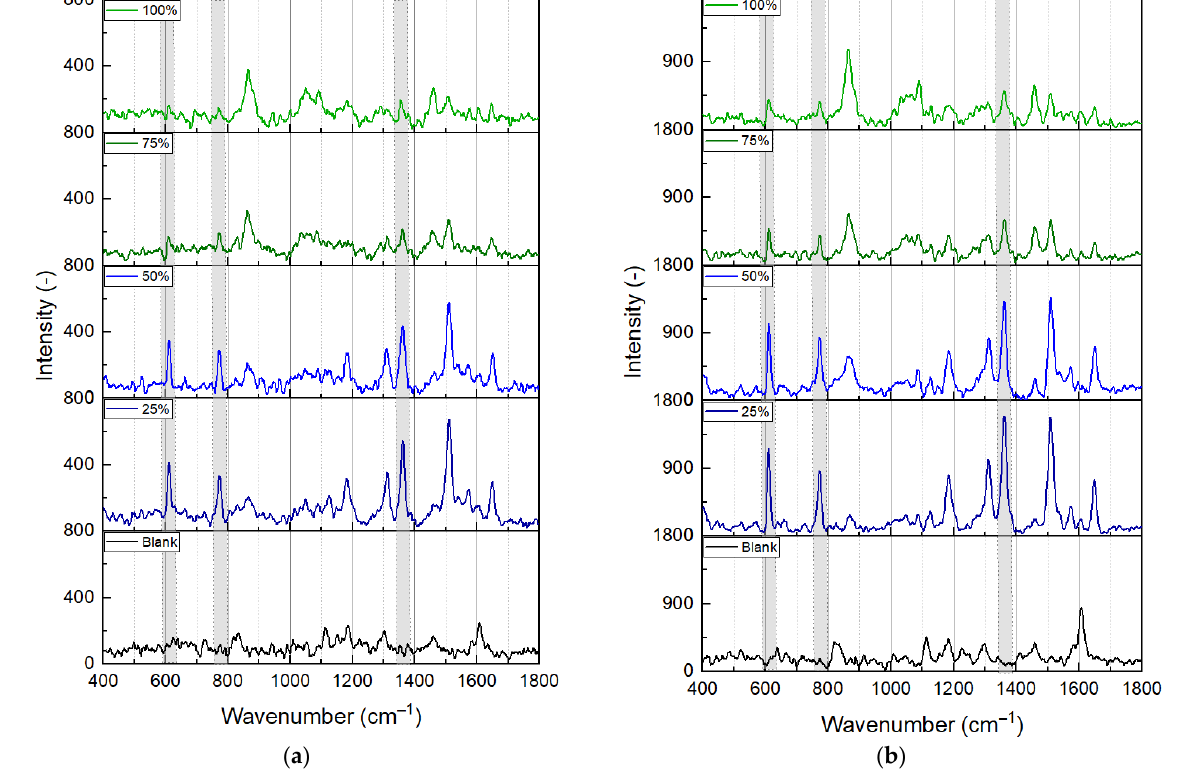
Figure 6. SERS spectra were obtained on a type #2 substrate with 633 nm excitation at different conditions. ( a ) 0.1 mW laser power, ( b ) 0.5 mW laser power. The reference was measured in air, without any sample in the microfluidic cell. The other spectra were obtained in ethylene-glycol/water mixtures in different ratios (25%, 50%, 75%, and 100%) containing 1 × 10 −4 M R6G. The presented spectra are baseline corrected. The vertical dashed lines and shadowed areas mark the three peaks characteristic of R6G that were used for further evaluation.